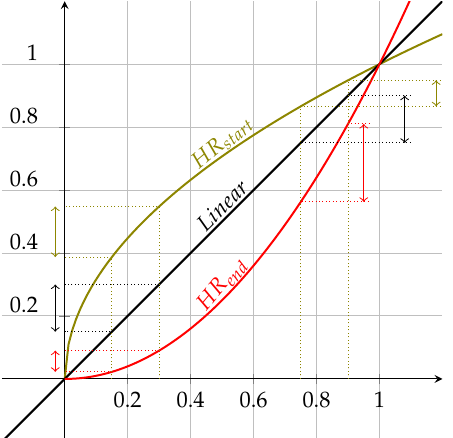
Figure 7. Example of user-defined utility functions. The graph shows the three function shapes currently available within